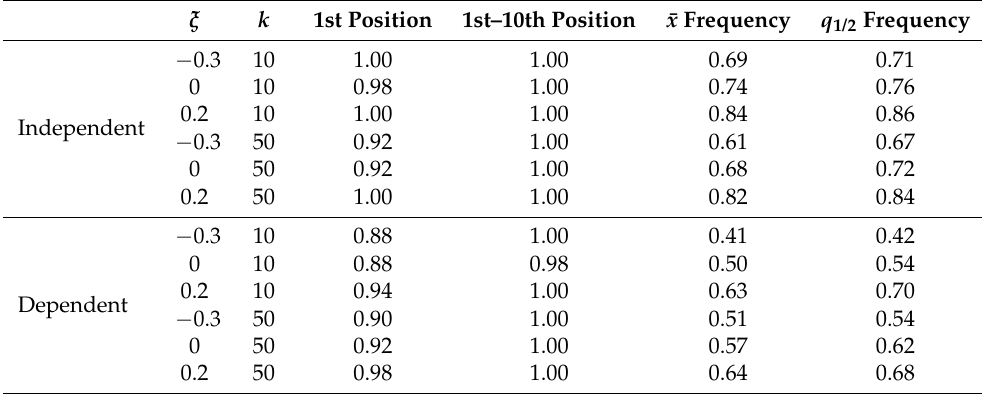
Table 1. Summary from the 50 simulations with data generated from the 12 models in the three first columns. The first position is the proportion of simulations where the true model is the most frequent in γ . The 1st–10th position is the same but is within the 10 most frequent models, i.e., promising models. ¯ x and q 1/2 frequency are the mean and median across simulations of the frequency of appearance of the true model in γ . ξ k 1st Position